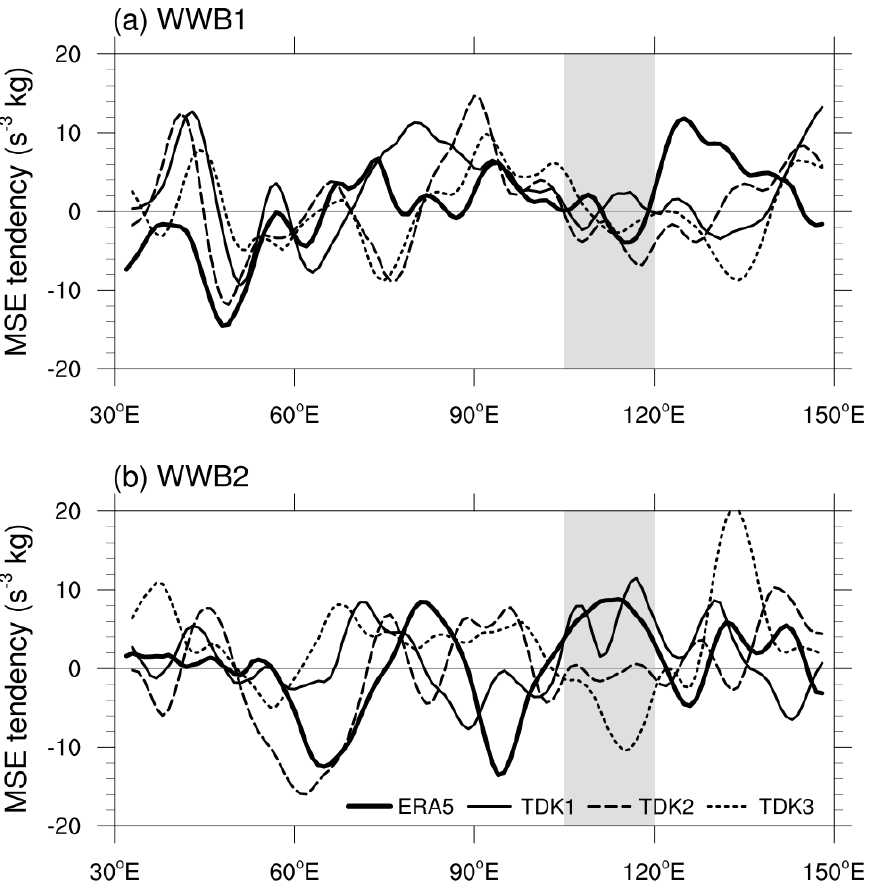
Figure 6. Zonal distribution of the column-integrated MSE tendency (W m − 2 ) averaged over 10 ◦ S–10 ◦ N from the ERA5 and three TDK experiments. Two-day averaged results are shown by black lines when the ( a ) WWB1 and ( b ) WWB2 convective centers are near the 90 ◦ E. The gray shaded area represents the analysis domain between 105 ◦ E and 120 ◦